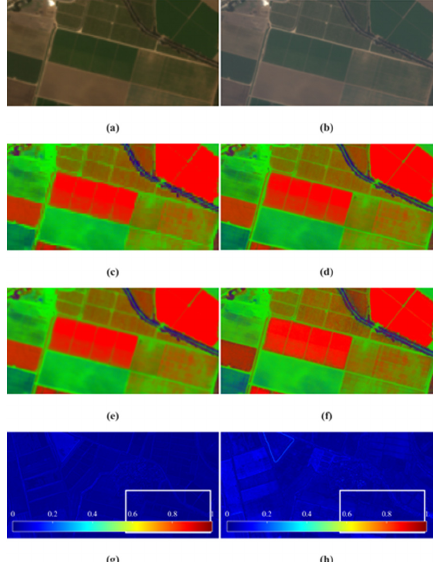
Figure 14. Zoon-in on the abundance fraction maps for three dominant EMs in the selected area for Test 3. ( a ) and ( b ) present RGB composites of the Venus 10 m and Venus 5 m images, respectively. ( c ) and ( d ) present corresponding fraction maps as obtained using the original spectral images with LSR 10 m and HSR 5 m (used as GT), respectively. ( e ) and ( f ) present corresponding fraction maps with HSR 5 m, as obtained using the image retrieved by the PSQ-PS method, and as obtained by the proposed fusion method DFuSIAL, respectively. ( g ) and ( h ) present full MAE maps of the fractions obtained by the PS and DFuSIAL methods, respectively. The white rectangle in ( g ) and ( h ) marks selected zoom-in area.